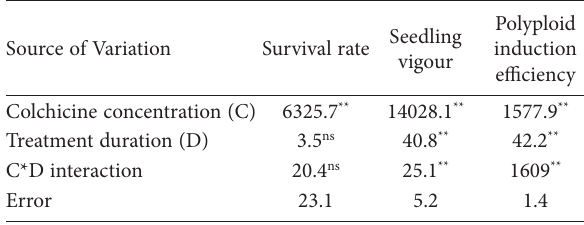
Table 1. ANOVA results (mean square) for the influence of colchi- cine concentration and duration on seedling vigor, survival rate, and octaploid induction efficiency in S.